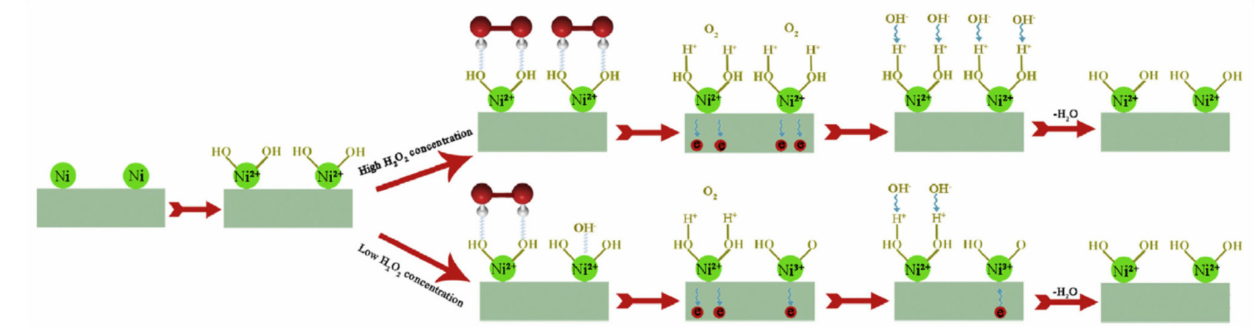
Figure 7. Schematic diagram depicting the mechanism for the H 2 O 2 electrooxidation on the Ni/Ni-foam electrode. The red and silver circles refer to the oxygen and hydrogen atoms in H 2 O 2 . Reprinted with permission from Ref. [125]. Copyright 2013